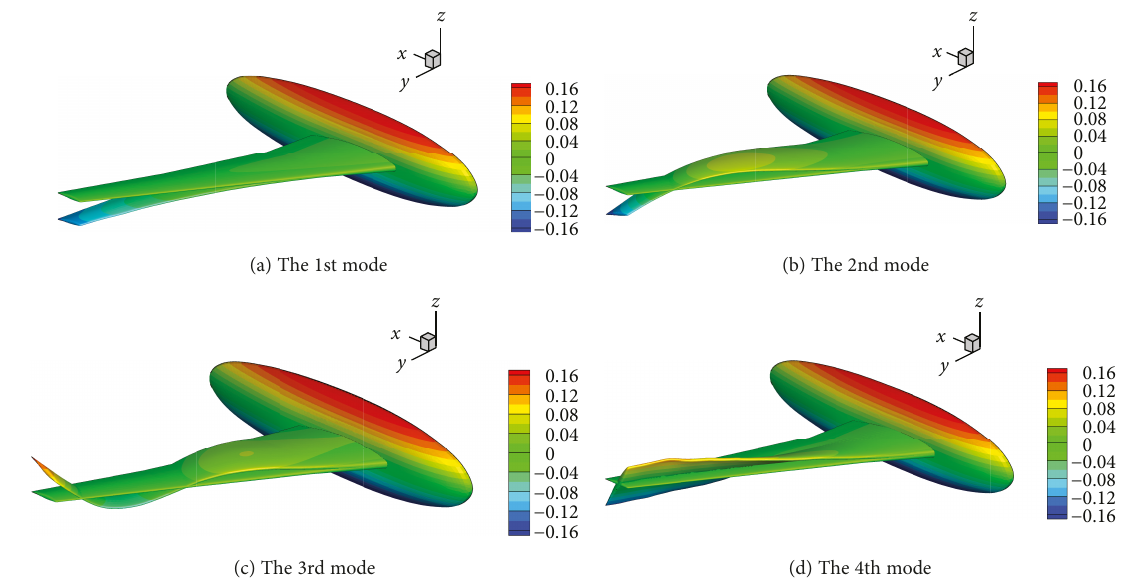
Figure 4: The shapes of the fi rst four modes used in the modal method (the contour plot of the height (unit: m); x : streamwise, y : spanwise, z : height). Table 2: The modal circular frequencies (unit: rad/s).